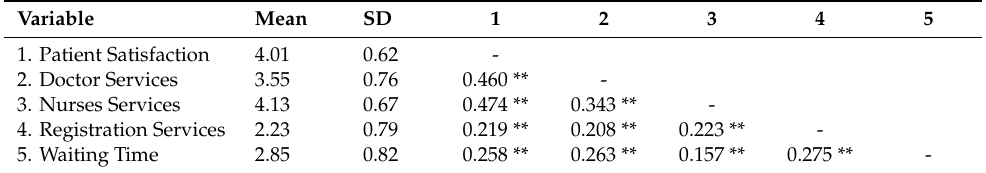
Table 2. Descriptive statistics, and correlations among variables.